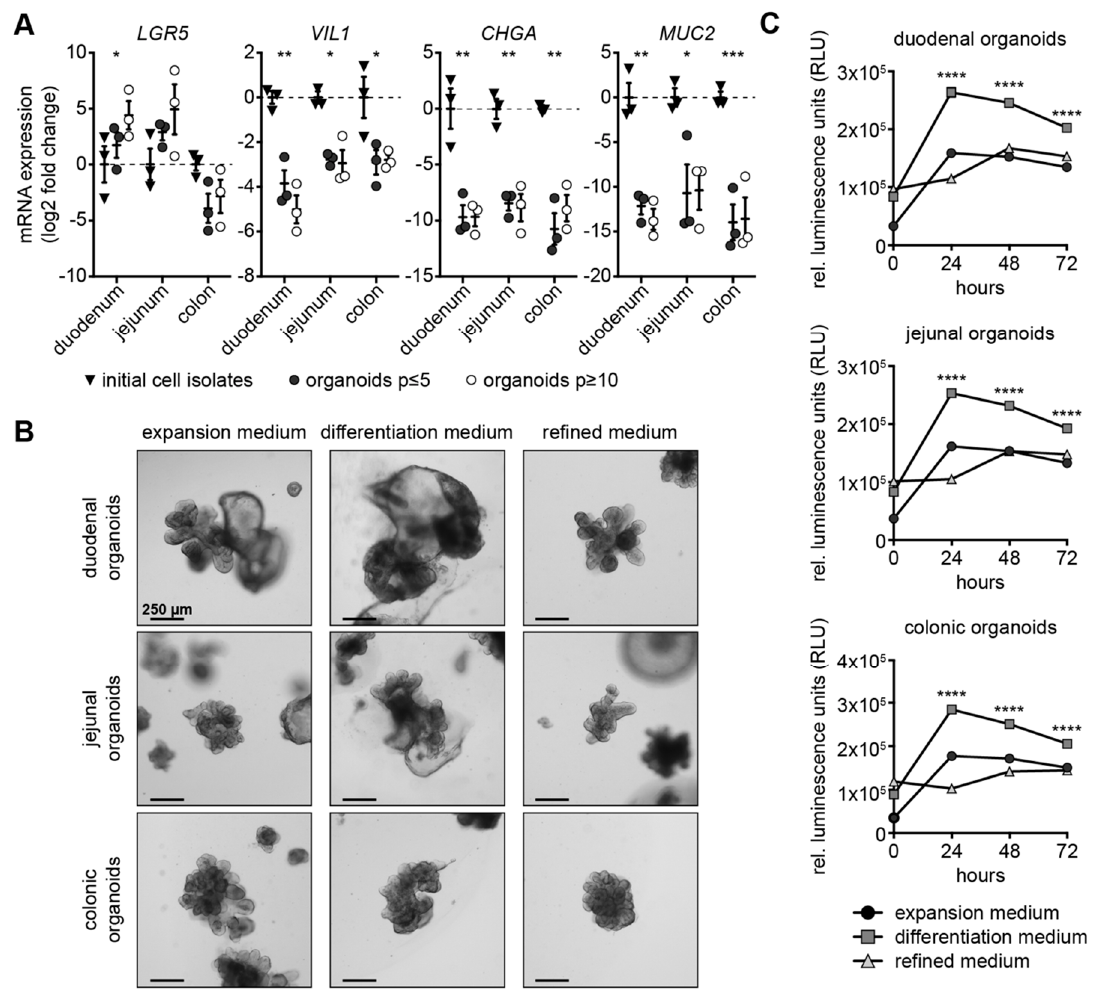
Figure 1. Establishment of new culture conditions for canine intestinal organoids. ( A ) RT-qPCR analysis of initial cell isolates (triangles), organoids with up to five passages (dark circles) and organoids with 10 or more passages (light circles) isolated from duodenum, jejunum or colon using LGR5 , VIL1 , CHGA and MUC2 primer. log2 fold changes normalized to expression of initial cell isolates are shown with scatter dot plots; mean is shown; whiskers present SEM; * p < 0.05, ** p < 0.01 and *** p < 0.001, statistical analysis given in detail in Supplementary Table S2-S4; n = 3 individual dogs. ( B ) Light microscopic images of organoids derived from duodenum, jejunum and colon cultivated in expansion, differentiation and refined medium four days after seeding; scale bars represent 250 µm. ( C ) Mean activity of Annexin V-induced luciferase is shown for 0, 24, 48 and 72 h after addition of substrate to duodenal, jejunal and colonic organoids in expansion (circle), differentiation (square) and refined medium (triangle); whiskers represent SEM; **** p < 0.0001; 50 organoids seeded per replicate; n = 6 replicates.